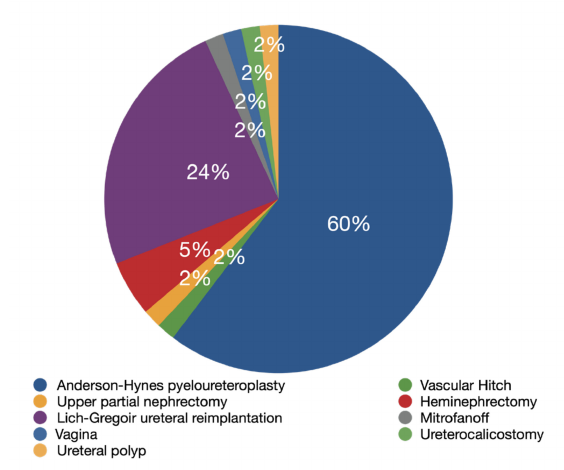
Figure 4. Major surgeries in Genitourinary Surgery.